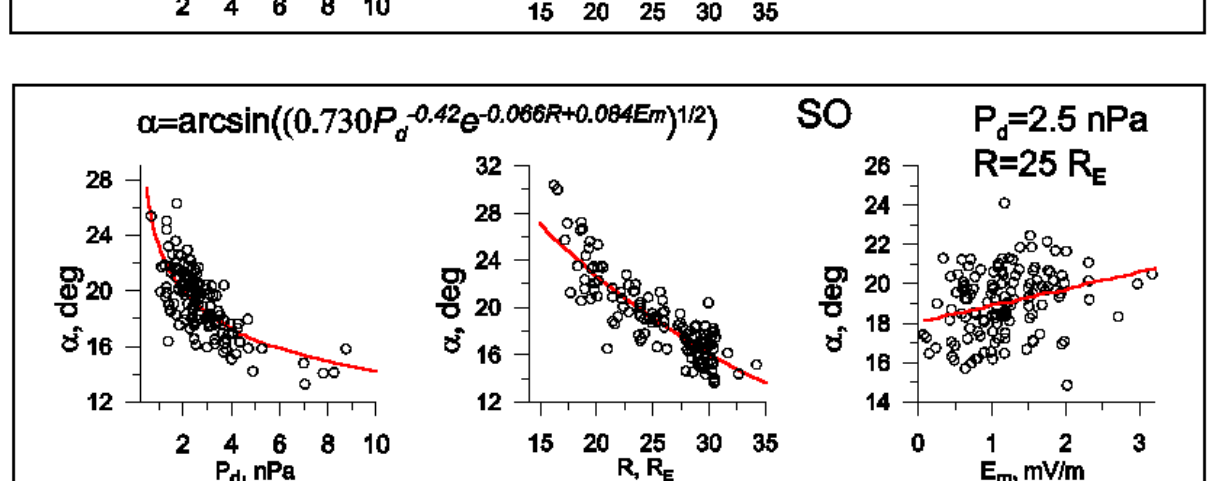
Fig. 4. The same as Fig. 3, but for the flaring